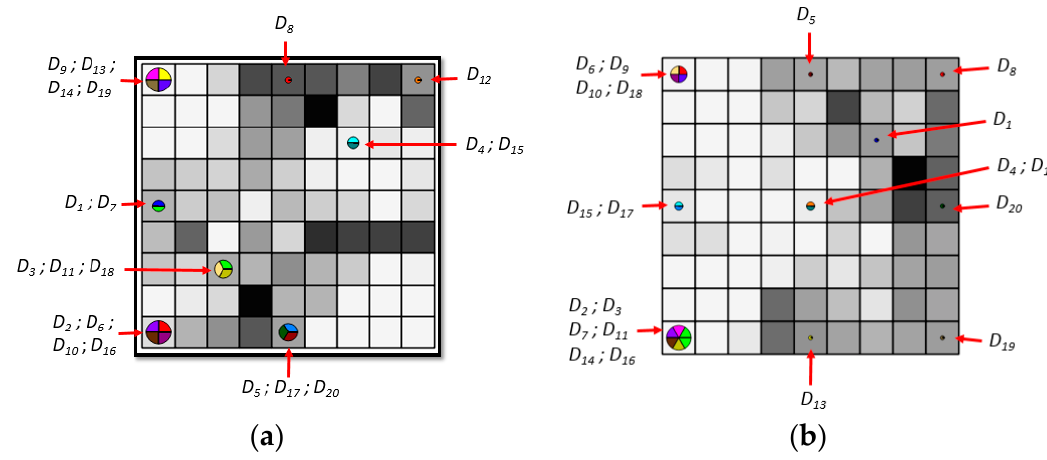
Figure 5. 9 × 9 self-organizing maps: ( a ) first question ( (cid:1843) (cid:2869) ); ( b ) second question ( (cid:1843) (cid:2870) ).